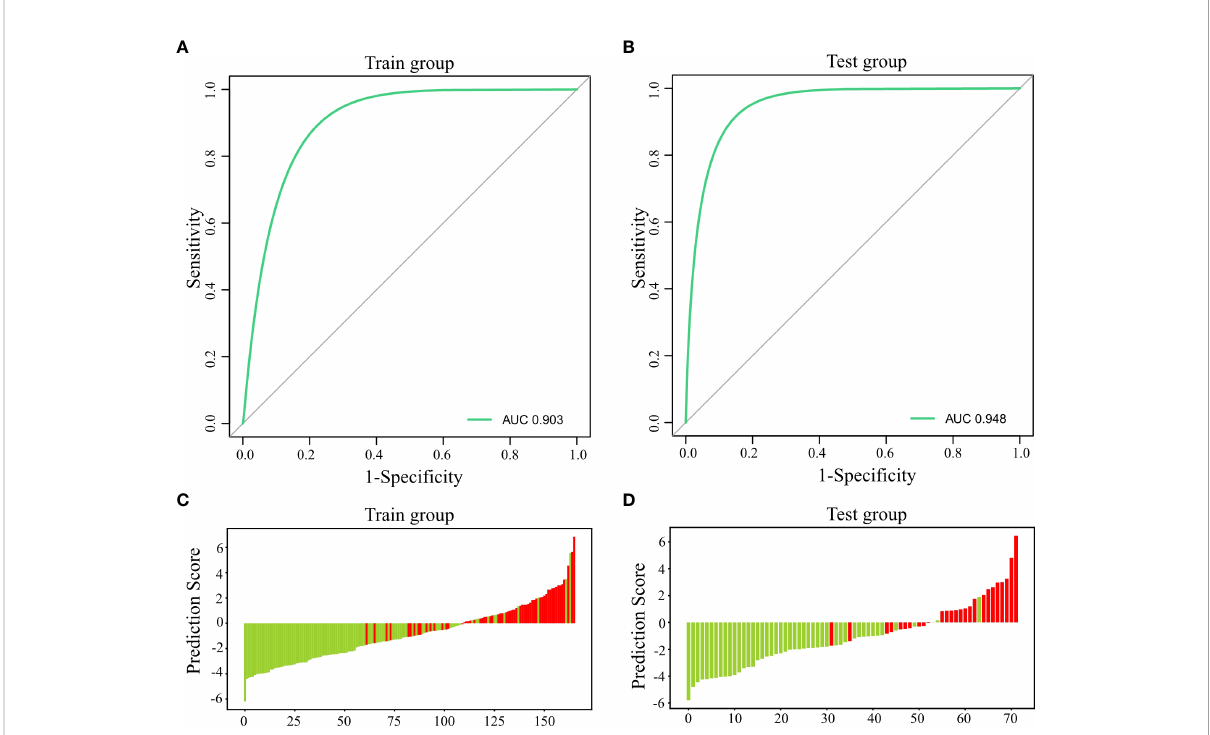
FIGURE 2 Predictive ef fi ciency and score for the predictive model. (A) AUC for the training group; (B) AUC for the test group; (C) Predictive score for the training group; and (D) Predictive score for the test